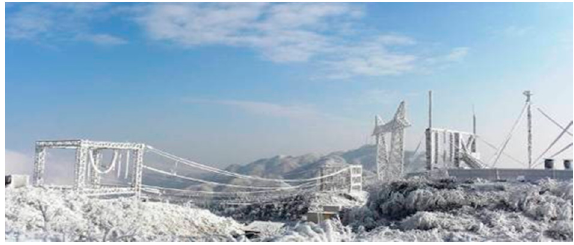
Figure 1. Aging environments of composite insulators in a high altitude area experimental station.